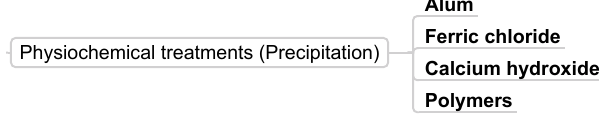
Figure 14. Partial taxonomy: Physicochemical